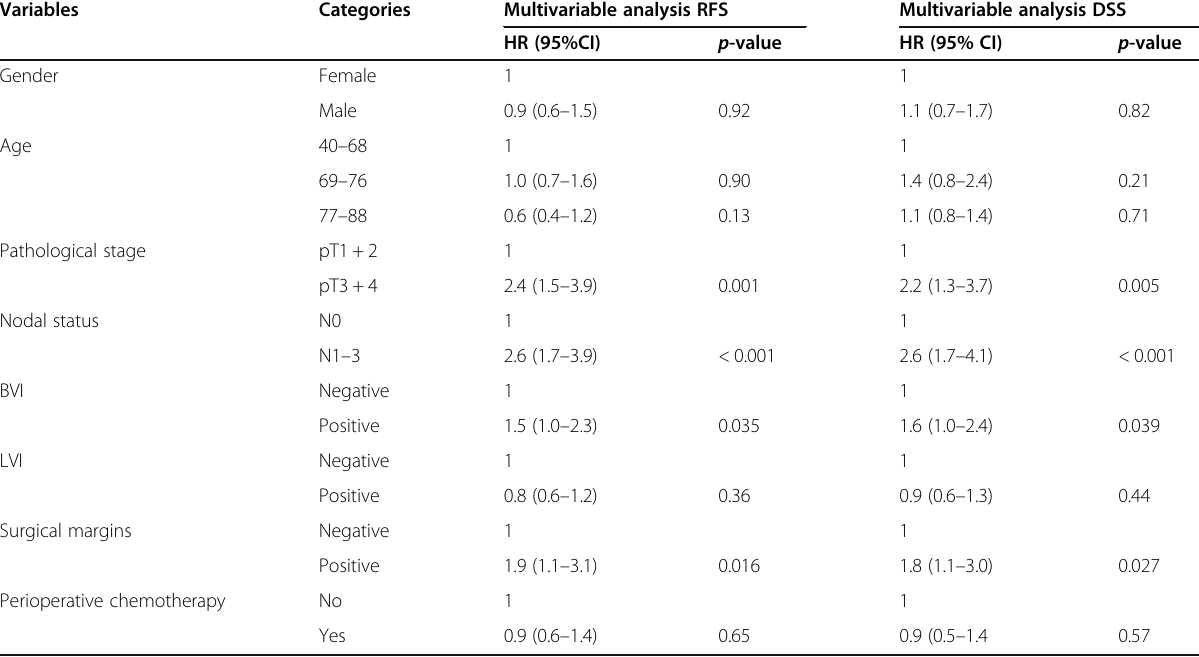
Table 3 Multivariable analyses of RFS and DSS of pathological variables and BVI and LVI (Cox proportional hazard method, n = 256*)